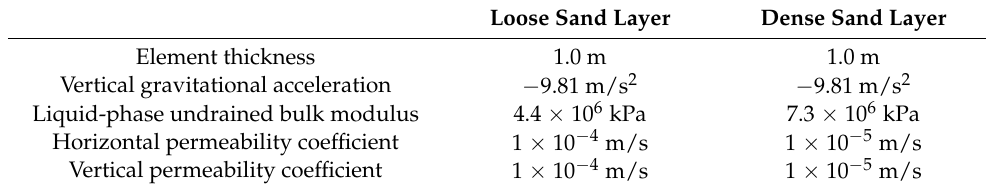
Table 2. Soil element parameters.